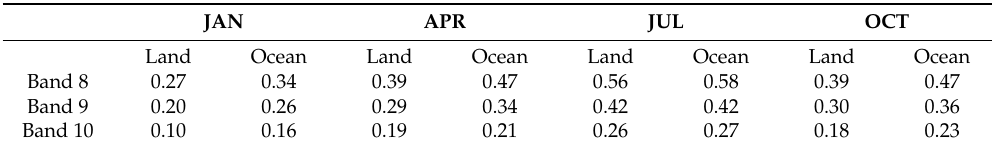
Table 2. The mean P over land and ocean in January, April, July and October of Band 8, Band 9 and Band 10. Units are